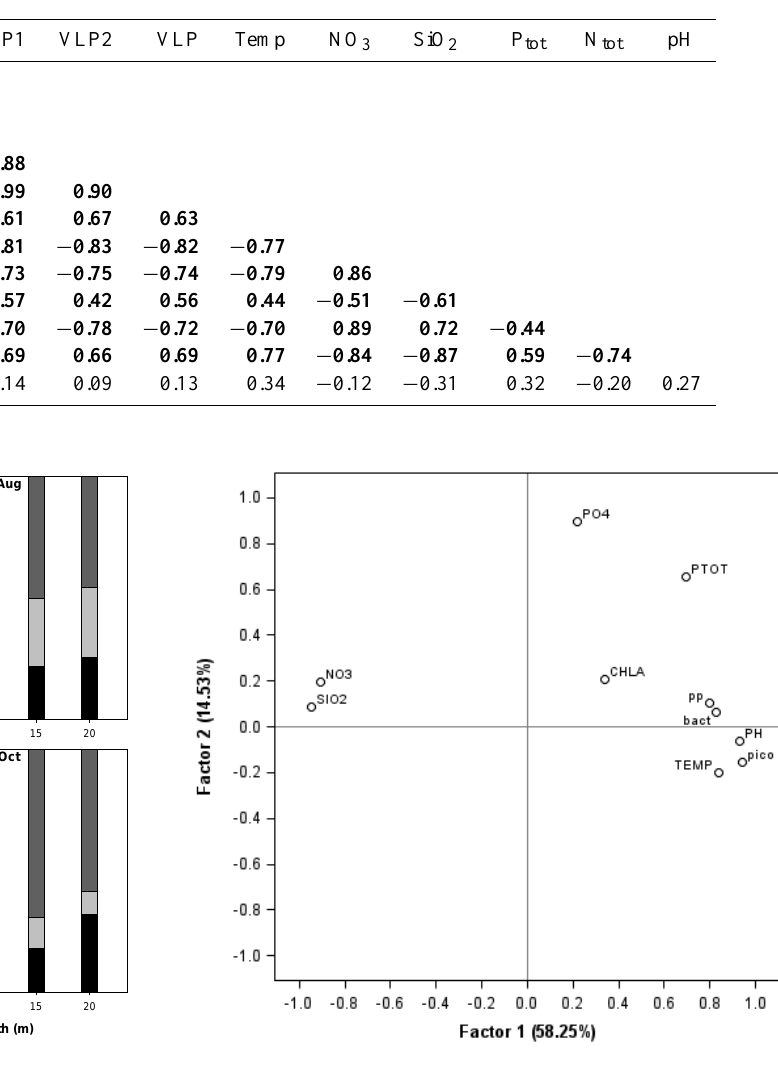
Fig. 6. Principal component regression analysis for bacteria, pico- cyanobacteria and other phytoplankton with the rest of the environ- mental variables. PO 4 (0.89) and P tot (0.64) were the major components